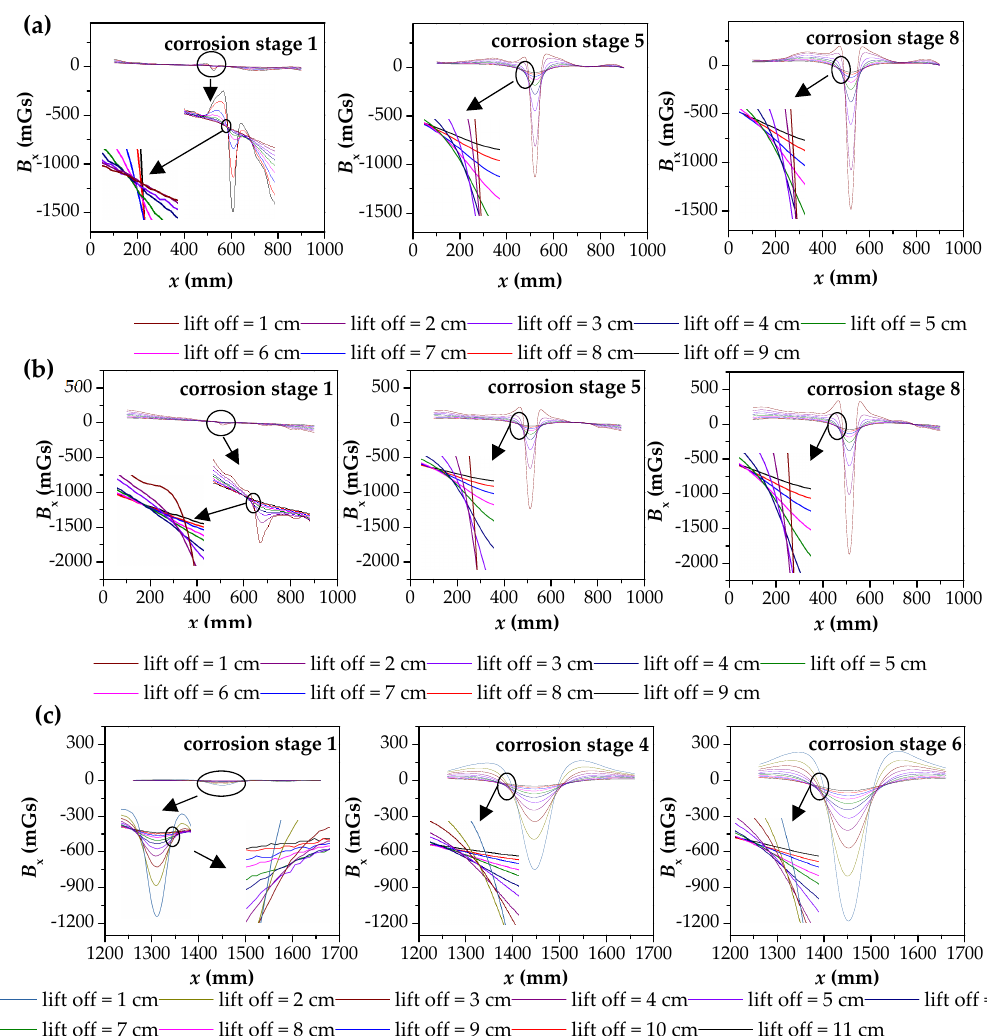
Figure 17. The obtained results of magnetic flux signals of three specimens at di ff erent corrosion stages: ( a ) the experimental results of P1 in corrosion stage 1, 5 and 8; ( b ) the experimental results of P2 in corrosion stage 1, 5 and 8; ( c ) the partial experimental results of S1 in corrosion stage 1, 4 and 6. P1: the parallel wire strand made of seven steel wires; P2: the parallel wire strand made of 19 steel wires; S1: the steel strand; B x : the magnetic flux component of x direction; x : the coordinate along the length of the specimens.